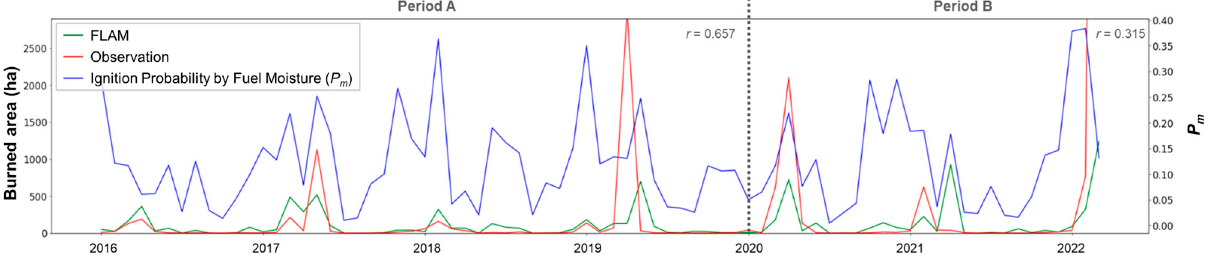
Figure 12. Temporal evaluation of burned area simulated by the optimized FLAM.